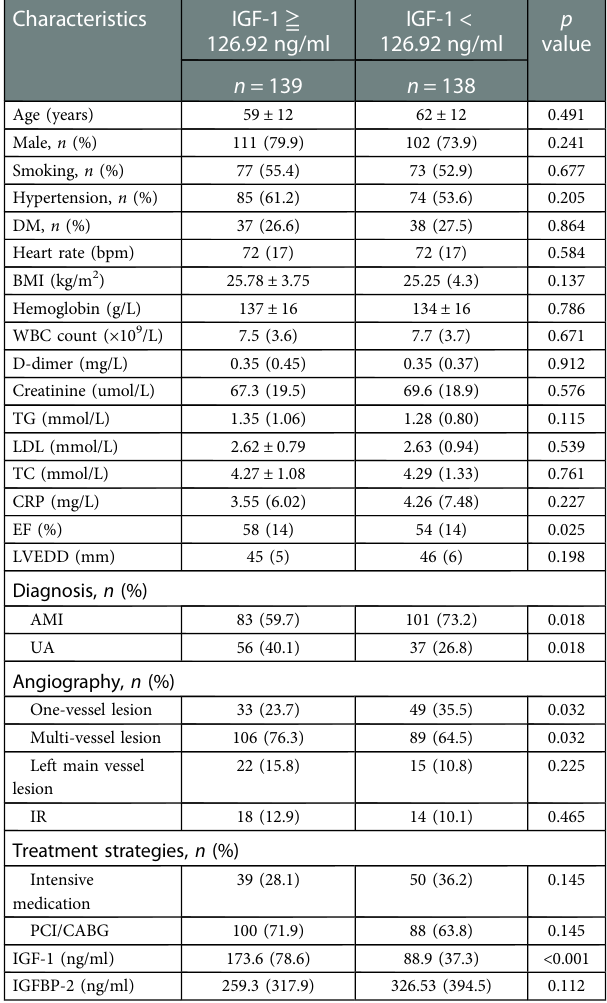
TABLE 2 Basic characteristics of studied patients according to plasma IGF-1